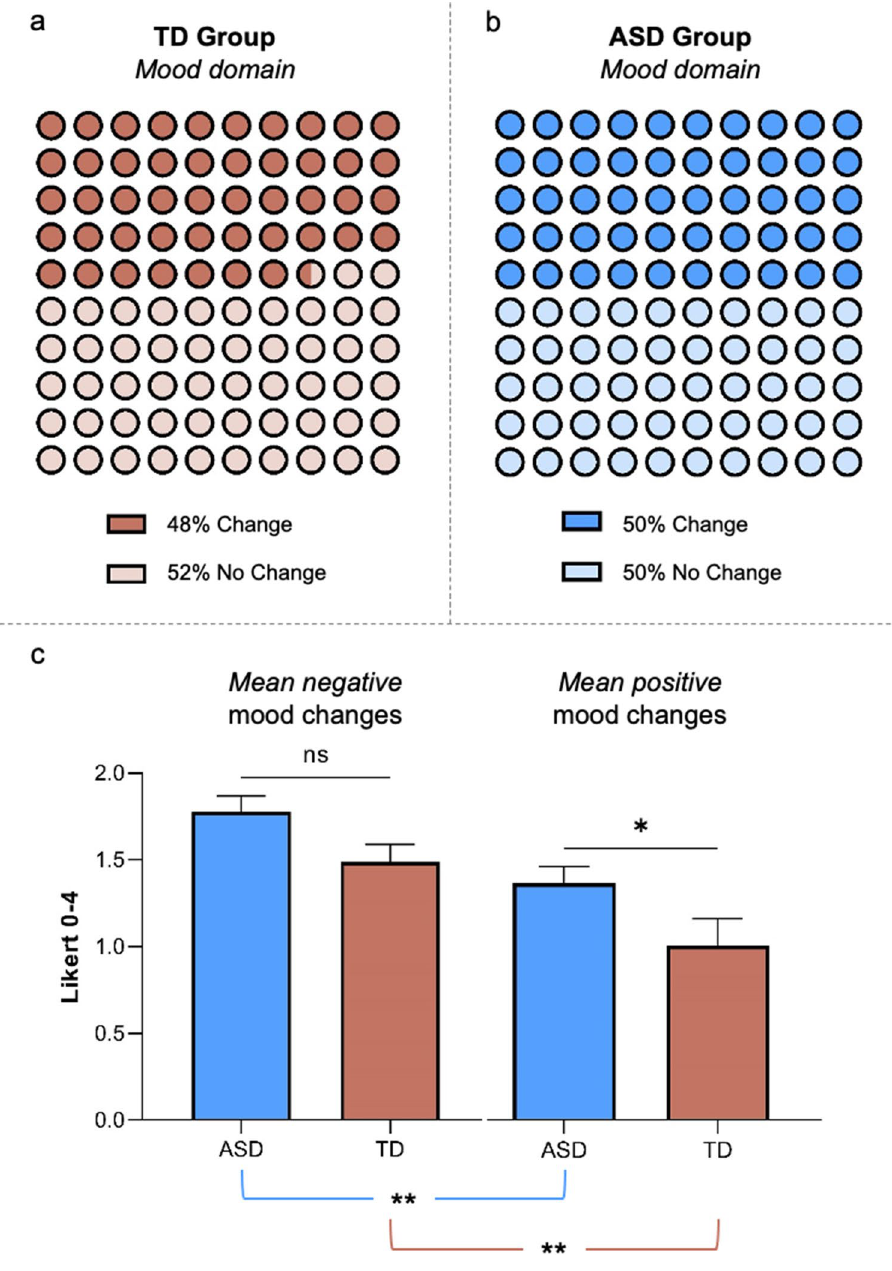
domain . ( c ) Graphs representing intra-group and inter-group comparisons in the mean negative and in the mean positive mood changes. Intra-group comparisons show that both ASD and TD children reported more mean negative than mean positive changes in mood (ASD group: p = 0.005; TD group: p = 0.004). Interestingly, there is no inter-group difference in the mean negative mood changes (ASD group: 1.78 ± 0.87; TD group: 1.49 ± 0.66; p = 0.10), but children with ASD reported more positive mood changes than TD children (ASD group: 1.31 ± 0.86; TD group: 0.97 ± 0.96; p = 0.019).*Statistical significance, p < 0.05; **statistical significance, p < 0.01; ns = no statistical significance. Bars represent standard errors of the mean